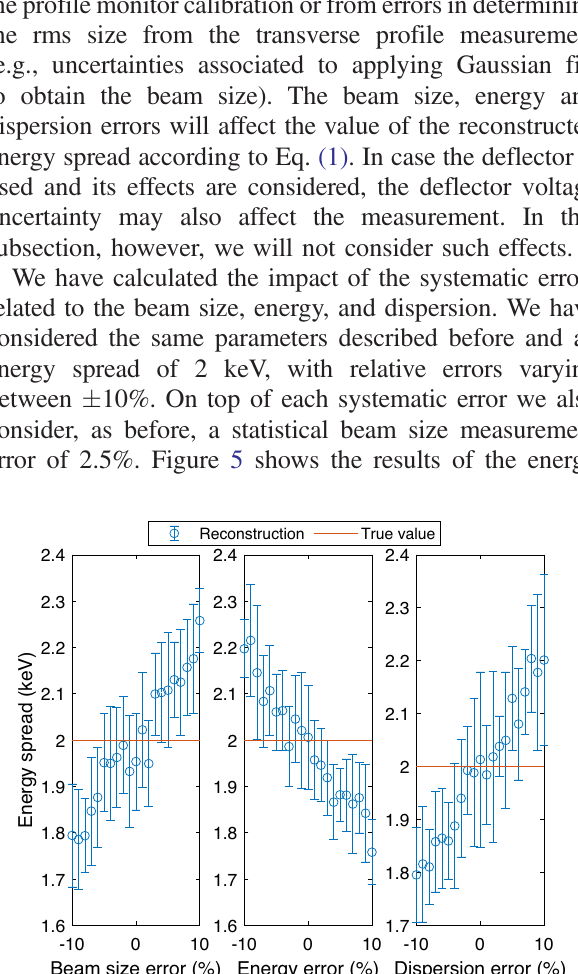
FIG. 3. Beam sizes at the profile monitor and the obtained fits for the different contributions for a particular example of the results of Fig. 2 with an energy spread of 1.5 keV.